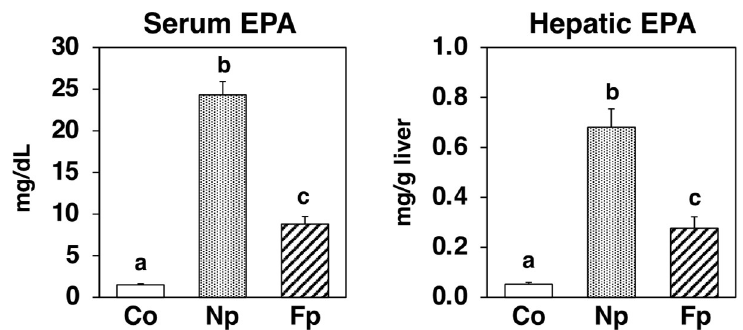
Figure 2. EPA levels in the sera and livers of db / db mice fed a basal diet (Co group), 10% NP-supplemented diet (Np group), or 10% FNP-supplemented diet (Fp group) for 4 weeks. Values are ex- pressed as the mean ± standard error (n = 5–6). abc Different letters denote significant differences ( p < 0.05) among the three groups. EPA: eicosapentaenoic acid.